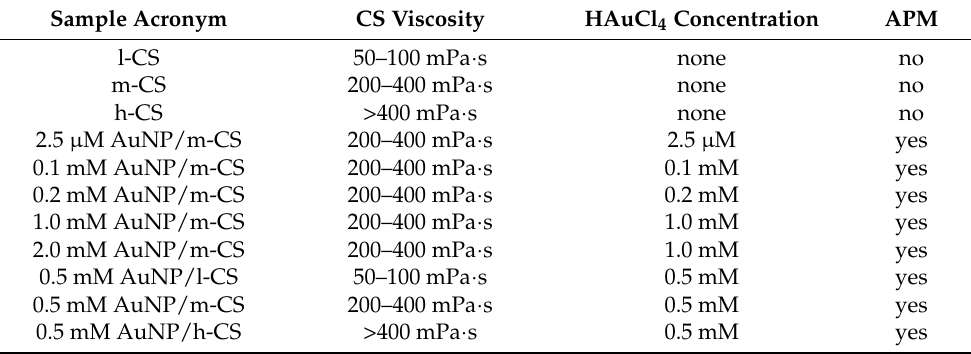
Table 1. Nomenclatures of samples and their preparation